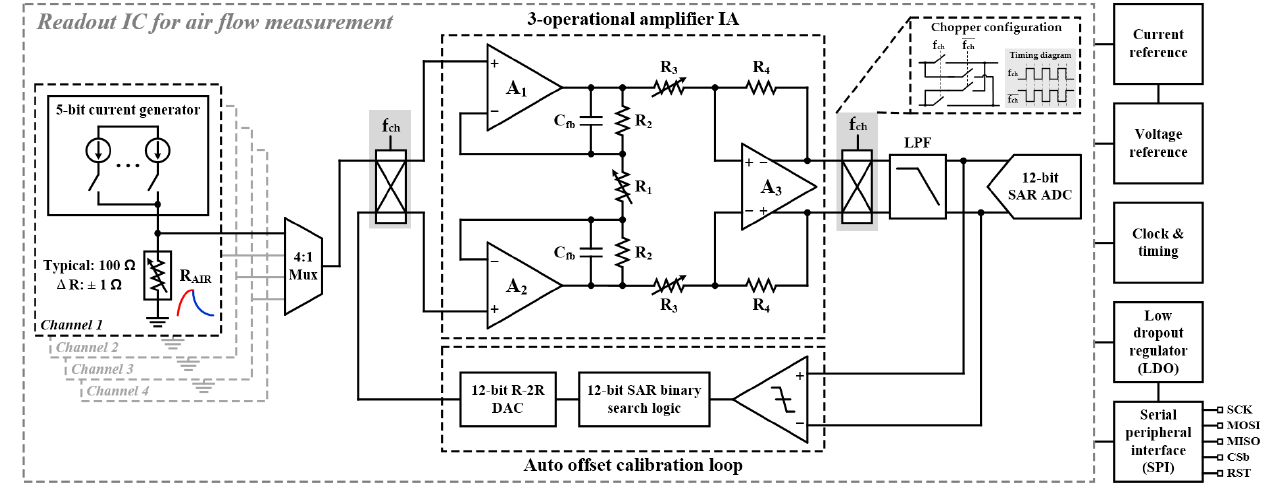
Figure 4. Top architecture of proposed four-channel low-noise readout IC for air flow measurement.